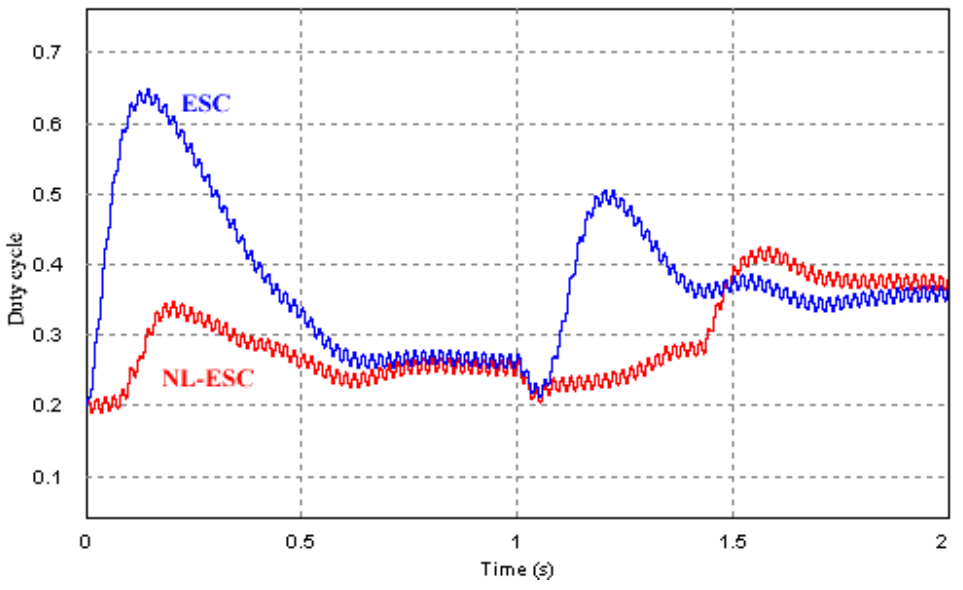
Figure 14. Transient of panel power in front an abrupt change of temperature in NL-ESC case ( Red ) and in ESC case ( Blue